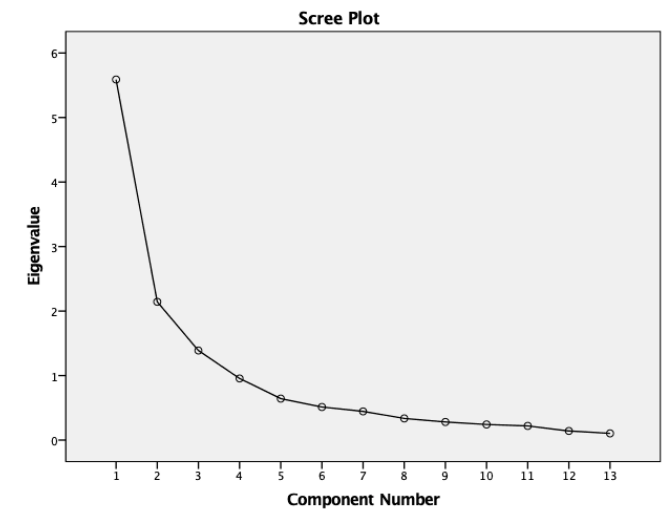
Figure 3. Scree plot of the final exploratory factor analysis (EFA) solution (three factors on 13 items). Table 4. Pattern matrix of the EFA solution (three factors, 13 items).